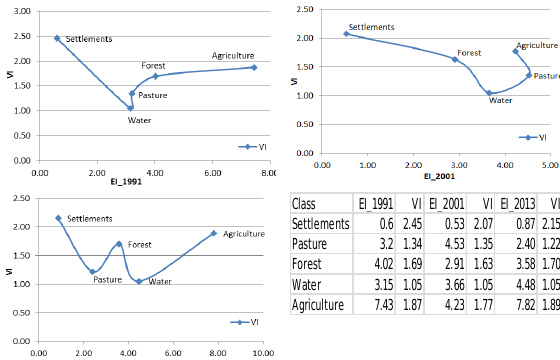
Figure 5. Correlation of Vulnerability Index (VI) and Exposure Index (EI).